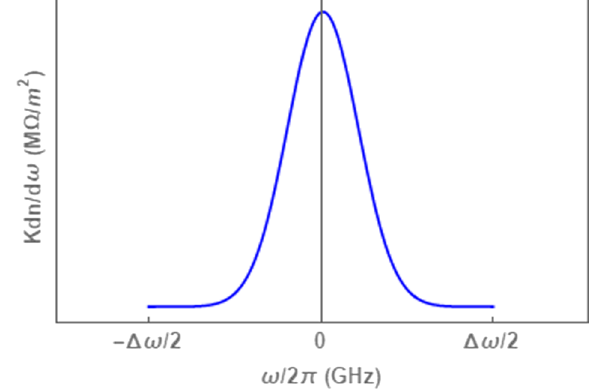
FIG. 25. The difference of the transverse wakefields calculated via the summation method (25) and the analytical expression (28) for θ ¼ 0 . 04 degrees and θ ¼ 0 . 12 degrees and L ¼ 0 . 5 m. Note that a restricted list of θ values have been used to make the behavior easier to interpret.